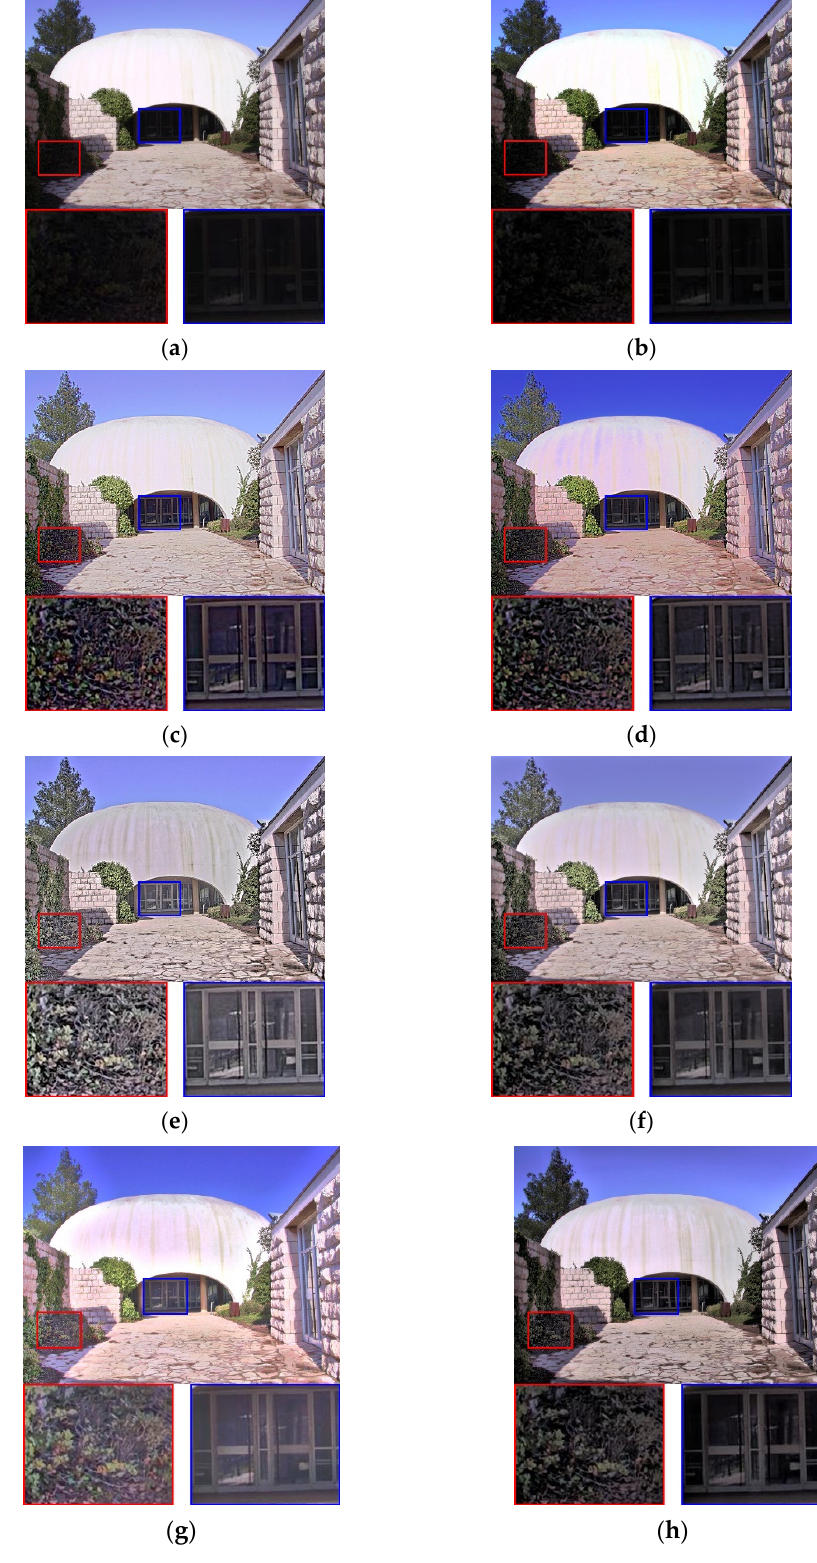
Figure 7. Visual comparison using the test image Synagoguei. ( a ) Result of [4]. ( b ) Result of [9]. ( c ) Result of [13]. ( d ) Result of [25]. ( e ) Result of [14]. ( f )Result of [17]. ( g ) Result of [18]. ( h ) Result of the proposed method.